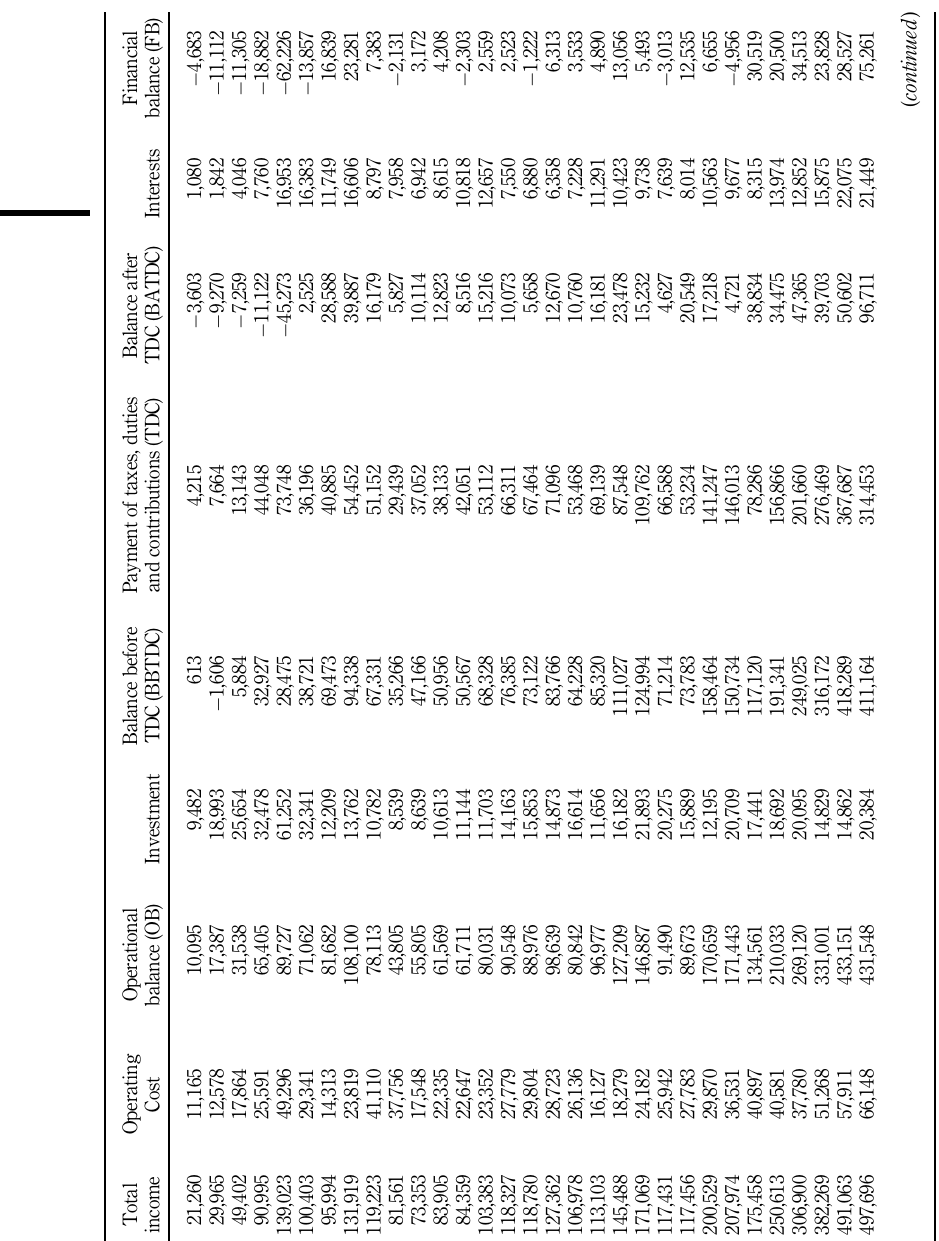
Table 2. Pemex ’ s